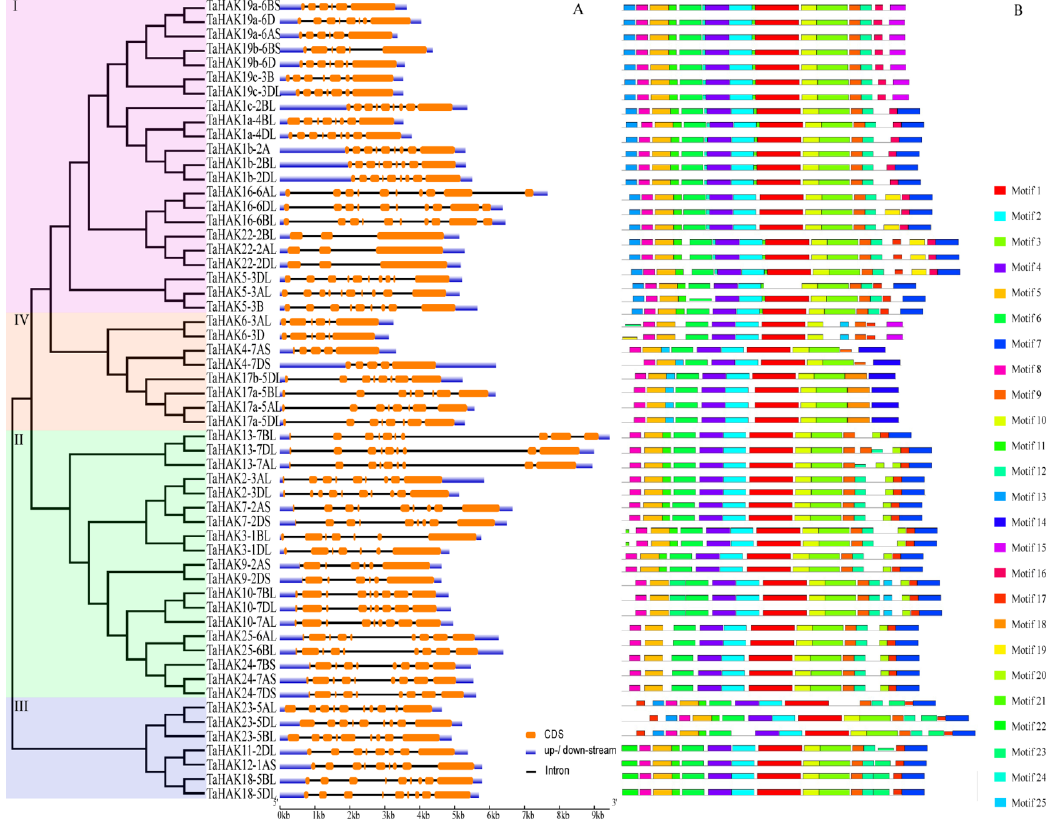
Figure 3. Gene structures and conserved protein motifs of TaHAK s. ( A) . Gene structures. TaHAK genes are displayed in order based on a phylogenetic analysis of their protein products. Introns, exons and noncoding regions are represented with black lines, orange boxes and blue boxes, respectively. ( B) . Conserved protein motifs. Twenty-five motifs identified in TaHAK proteins marked by different colors.